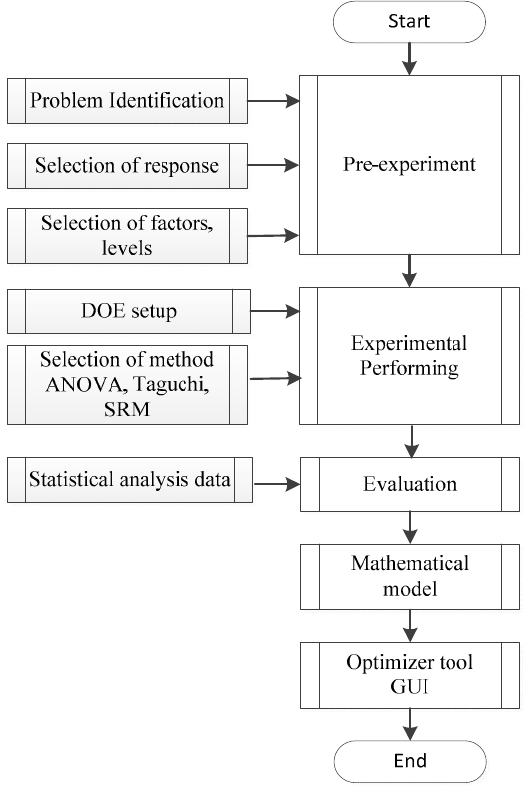
Figure 16. A schema of the process optimisation system.